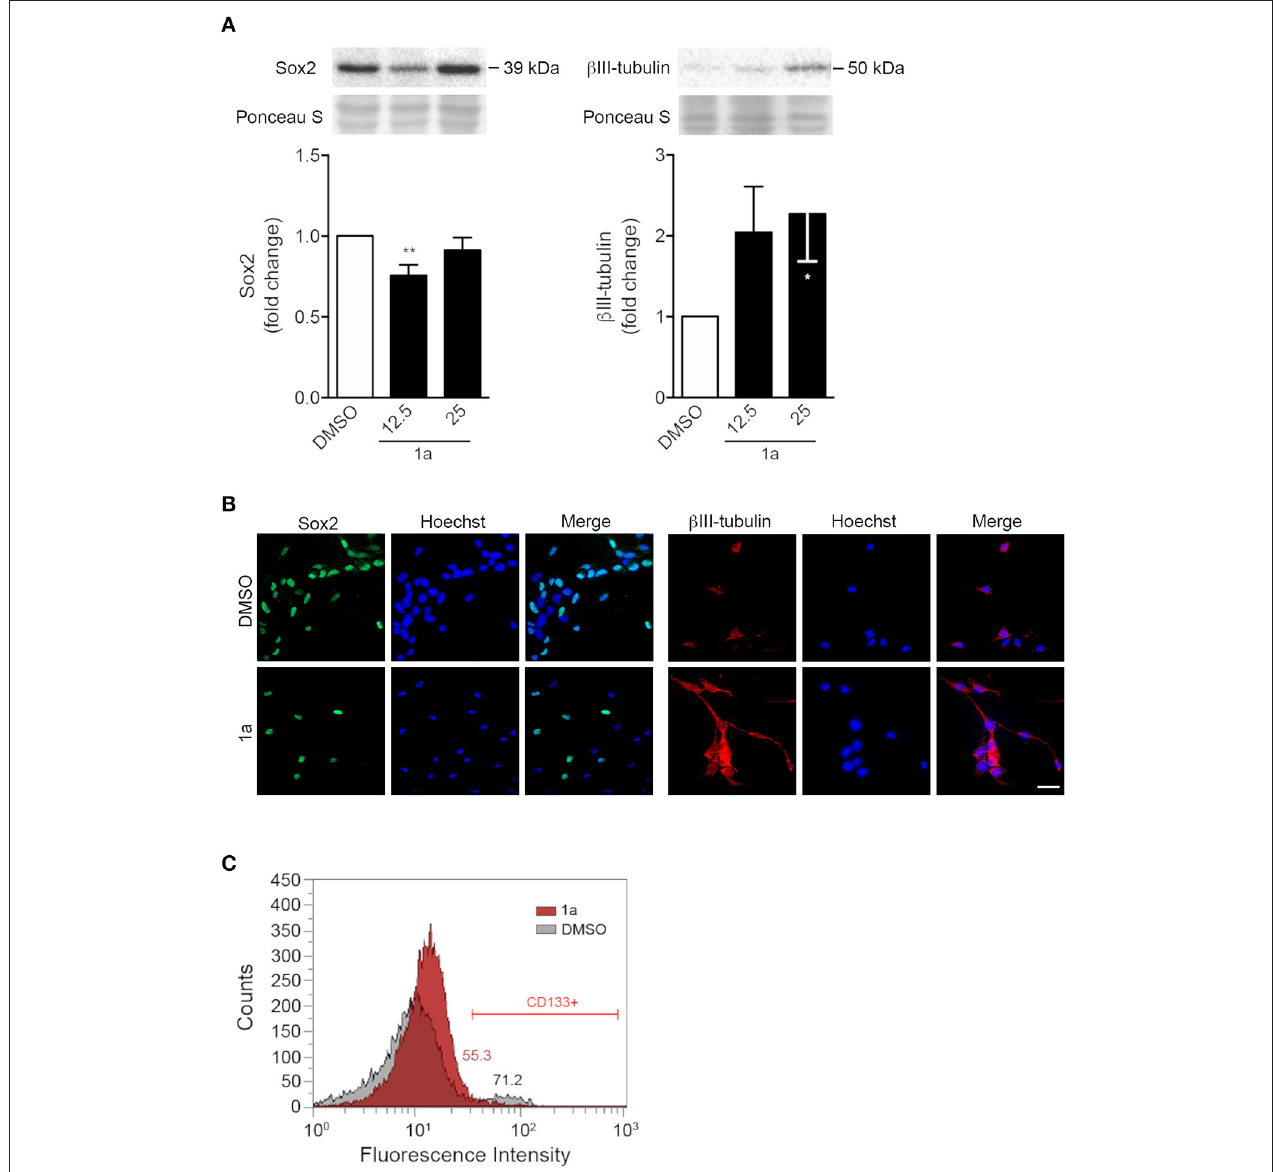
FIGURE 4 | Spiropyrazoline oxindole 1a decreases stemness and increases differentiation of NSCs. Mouse NSCs were grown in differentiation medium, incubated with 12.5 or 25 µ M 1a or DMSO (control) for 24h and collected for Western blot and immunocytochemistry as described in Experimental . (A) Representative immunoblots (top) and corresponding densitometry analysis (bottom) showing decreased Sox2 (left) and increased β III-tubulin (right) protein levels after 1a treatment. Ponceau staining was used as loading control. Data represent mean ± SEM of at least three independent experiments. * p < 0.05 and ** p < 0.005 from respective control by Student’s t -test. (B) Representative images of immunofluorescence detection of Sox2 (left) and β III-tubulin (right) after 24h of 1a treatment at 12.5 µ M. Nuclei were stained with Hoechst 33258. Scale bar, 25 µ m. (C) Flow cytometry histograms showing surface marker expression of stemness-associated CD133, after treatment with vehicle (gray) or 1a at 12.5 µ M (red) for 24h, and respective quantification of CD133-positive cells mean fluorescence